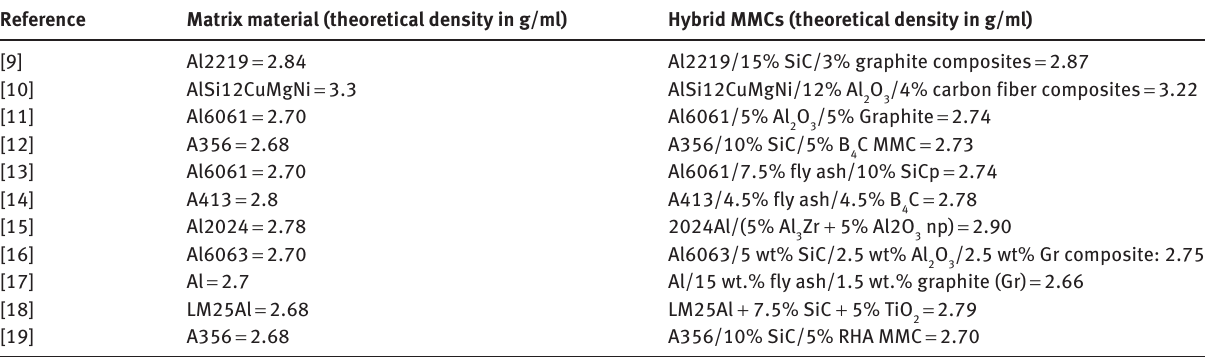
Table 1: Hybrid metal matrix composites with different reinforcements [9–19].